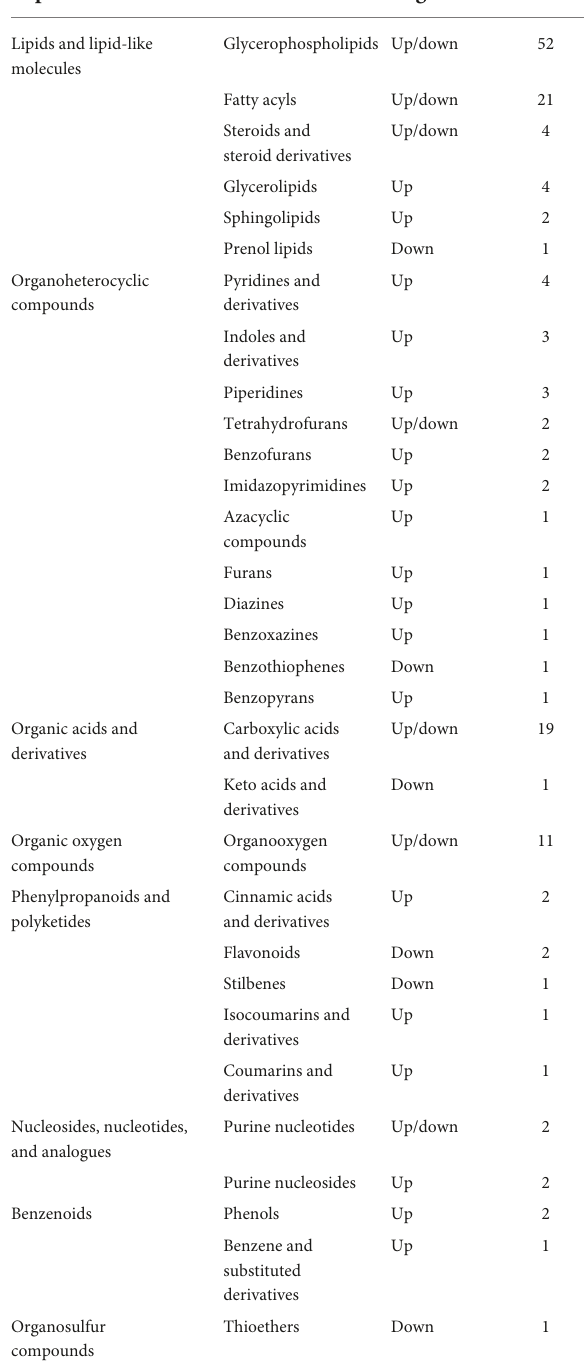
TABLE 2 The classification of significantly different metabolites of mulberry